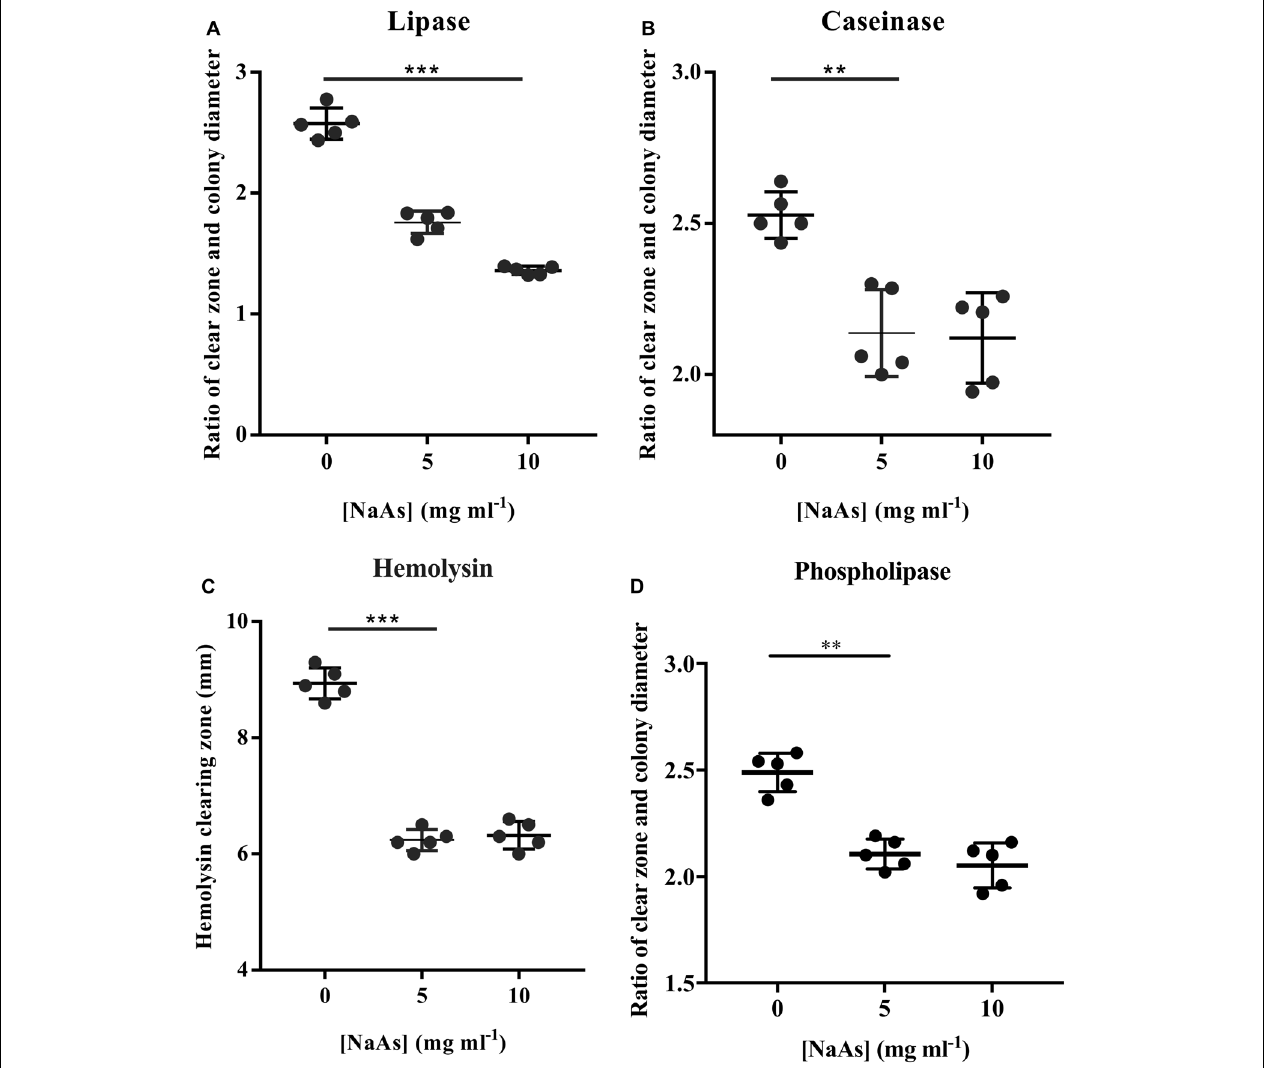
FIGURE 4 | Activities of (A) Lipase, (B) Caseinase, (C) Hemolysin, and (D) Phospholipase of V. campbellii incubated with NaAs. The activities of the virulent determinants were expressed as the ratio of clear zone (mm) and colony diameter (mm). Results are expressed as mean ± standard error of three replicates. P ∗∗ in the graph indicates P < 0.01 and P ∗∗∗ indicates P < 0.001 (One-way ANOVA with Duncan’s post hoc